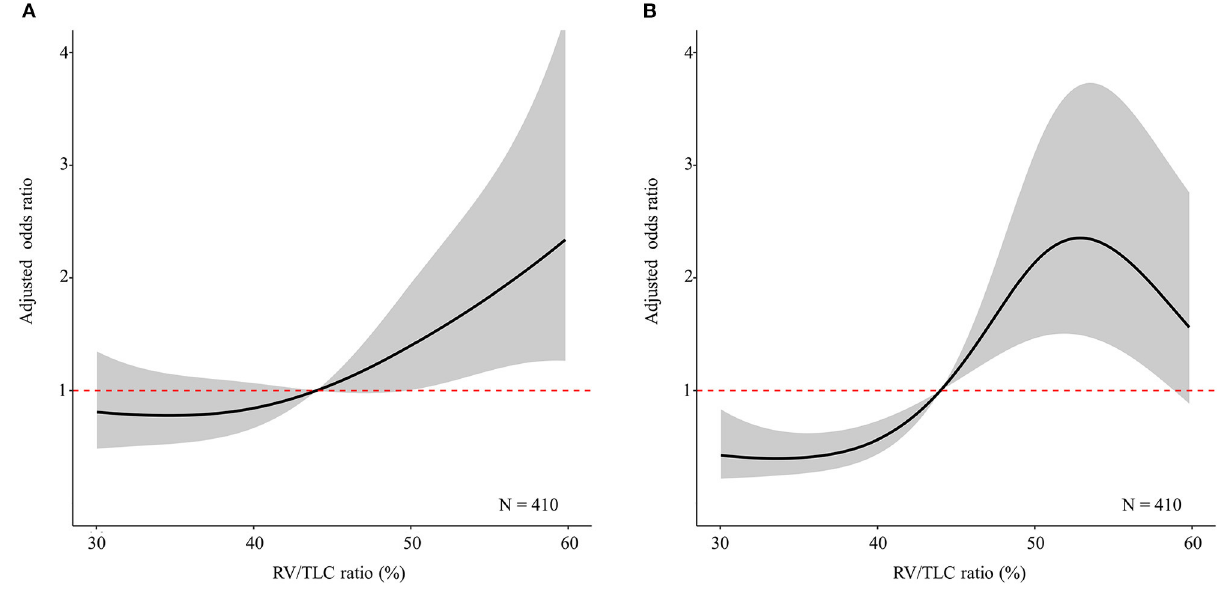
FIGURE 3 | The restricted cubic splines curve of multivariable logistic regression analysis according to the RV/TLC ratio. The solid line indicates the adjusted odds ratio according to the RV/TLC ratio. The shaded region represents the 95% confidence interval for the adjusted odds ratio according to the RV/TLC ratio. (A) Moderate to severe exacerbation. (B) Severe exacerbation. RV, residual volume; TLC, total lung